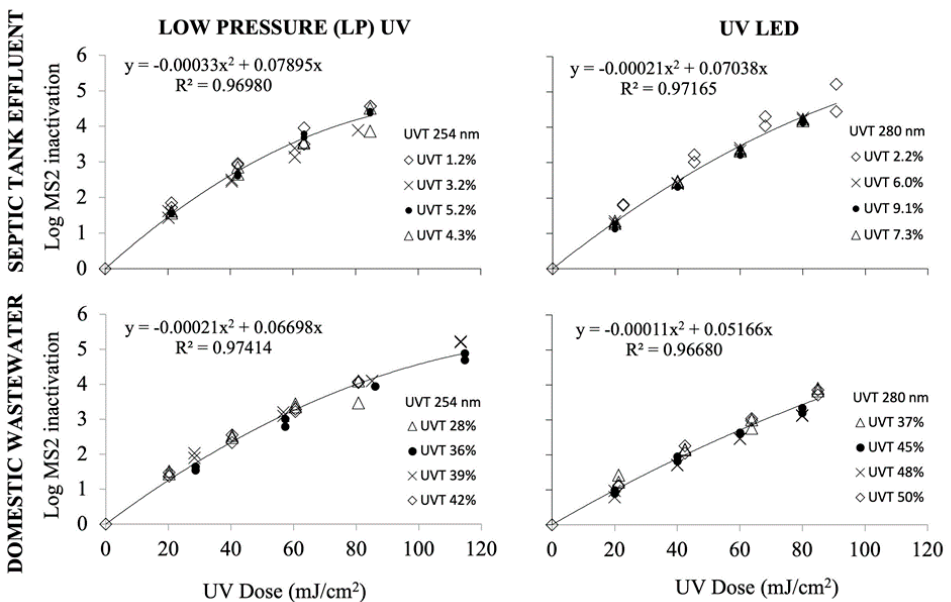
Figure 6. Dose response curves of MS2 bacteriophage in septic tank and domestic wastewater permeates. These collimated beam tests with the batch reactors were used to determine the UV dose in our flow-through reactors.